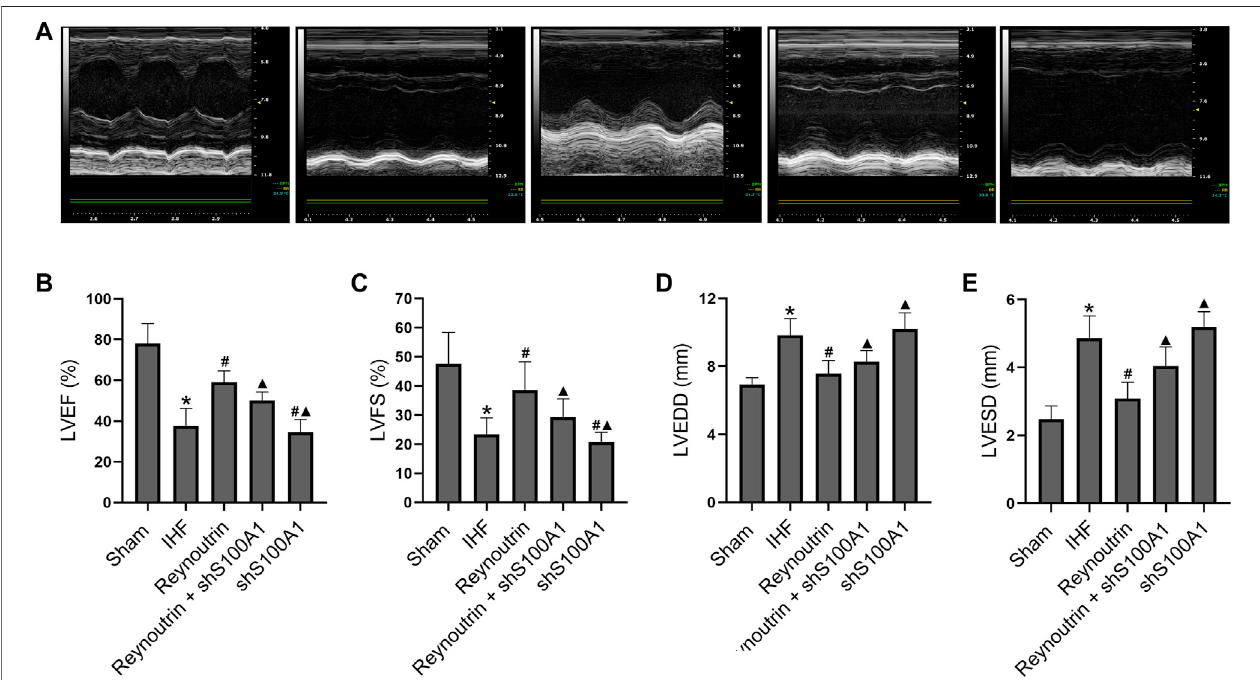
FIGURE4| EffectsofreynoutrinandS100A1knock-downoncardiacfunctionofrats.Thedoseofreynoutrinherewas50 mg/kg. (A) Therepresentativeimagesof echocardiogram of each group. (B) LVEF histogram of each experimental group. (C) LVFS histogram of each experimental group. (D) LVEDD histogram of each experimentalgroup. (E) LVESDhistogramofeachexperimental group.Thevaluespresented asthemeans ± standarderrorineachexperimentgroup( n (cid:1) 10).* p < 0.05 vs. Sham group; # p < 0.05 vs. IHF group; ▲ p < 0.05 vs. Reynoutrin group.